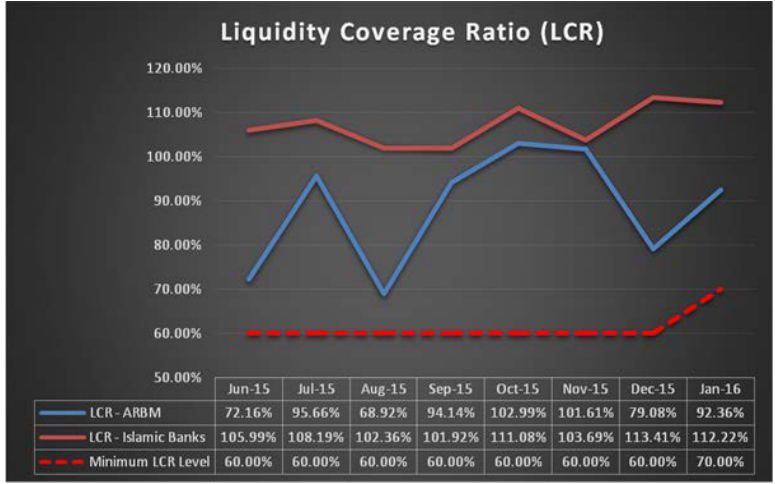
Figure 4. Graphical Presentation of liquidity coverage ratio (LCR).